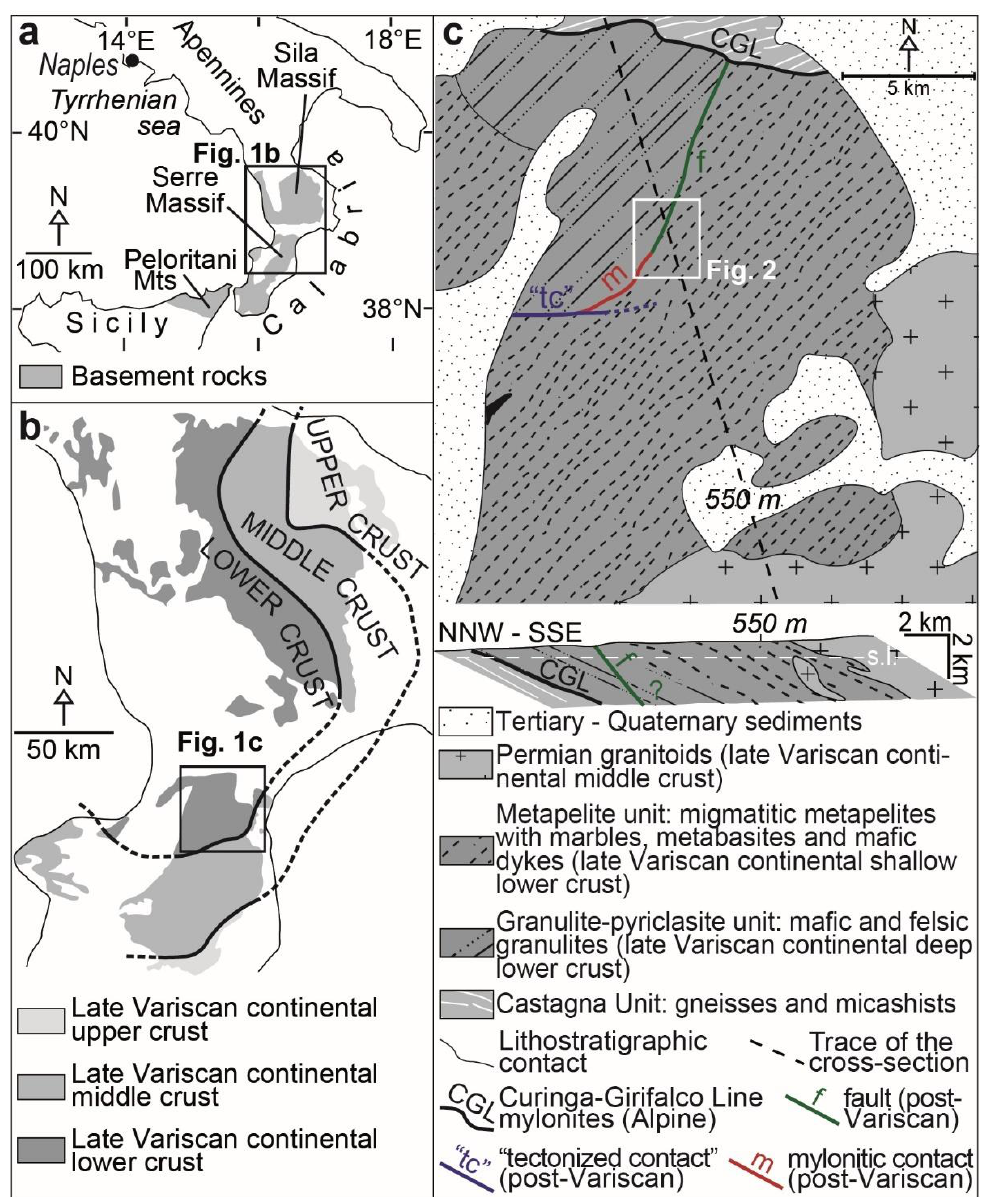
Figure 1. ( a ) Sketch map showing the distribution of basement rocks exposed in Southern Italy (after [5], modified). ( b ) Sketch map of the lower, middle, and upper late-Variscan continental crust exposed in Calabria (after [6], modified). ( c ) Geological sketch map of the northern Serre Massif and regional cross-section (after [7], modified): the traces of the post-Variscan “tectonized contact” (“tc”), mylonitic contact (m) and fault (f) are shown.